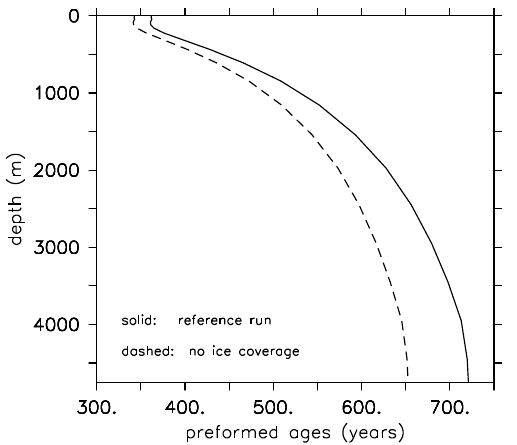
Figure 8. Sensitivity of preformed 14 C-age to ice cover. Solid line: control with ice cover affecting CO 2 gas exchange; dashed: effect of ice cover on CO 2 gas exchange ignored. Results are from the ECCO model, both runs use identical circulation.